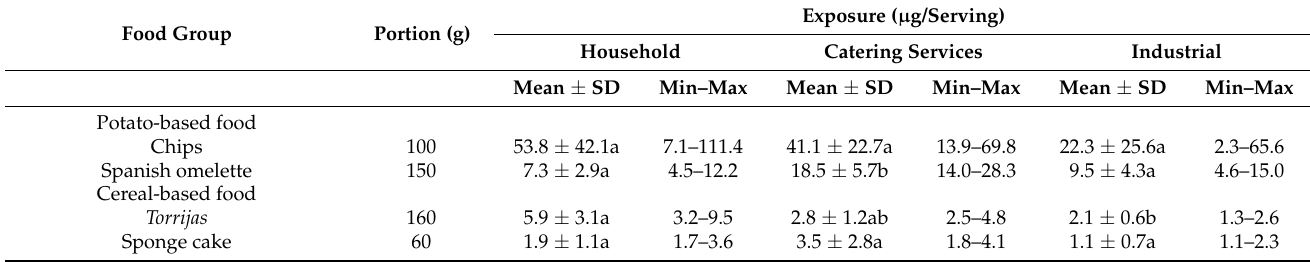
Table 3. Estimation of acrylamide exposure from different food groups and settings. Food Group Portion